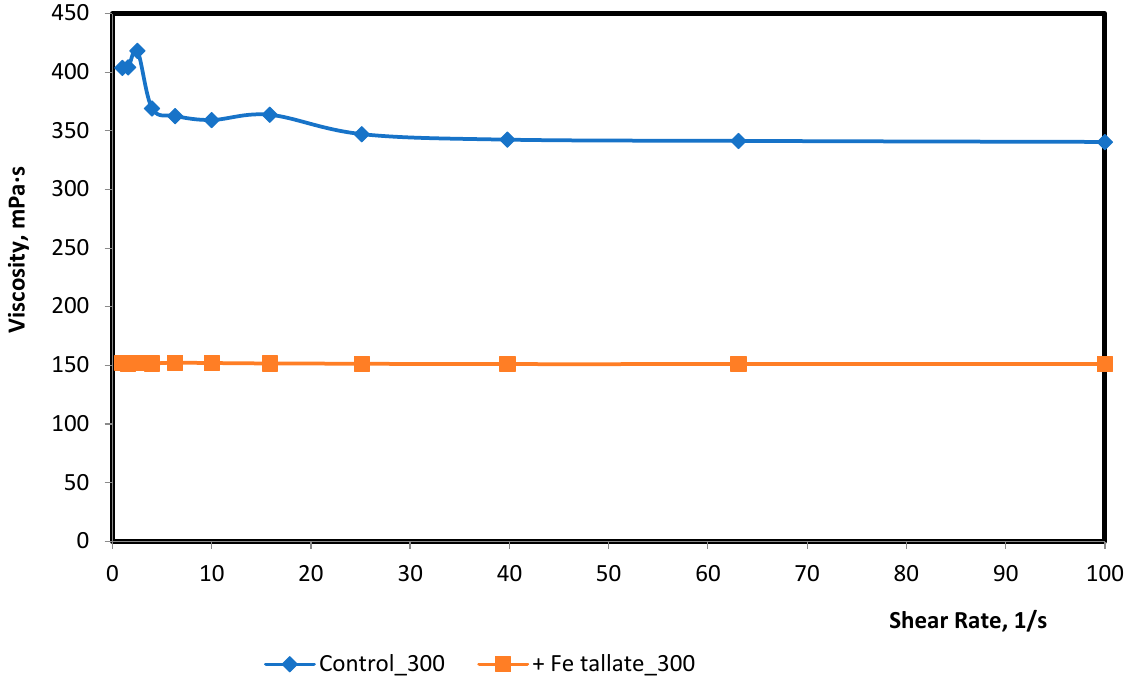
Figure 8. Viscosity-temperature characteristics of control experiment and oils after TST with iron tallate.